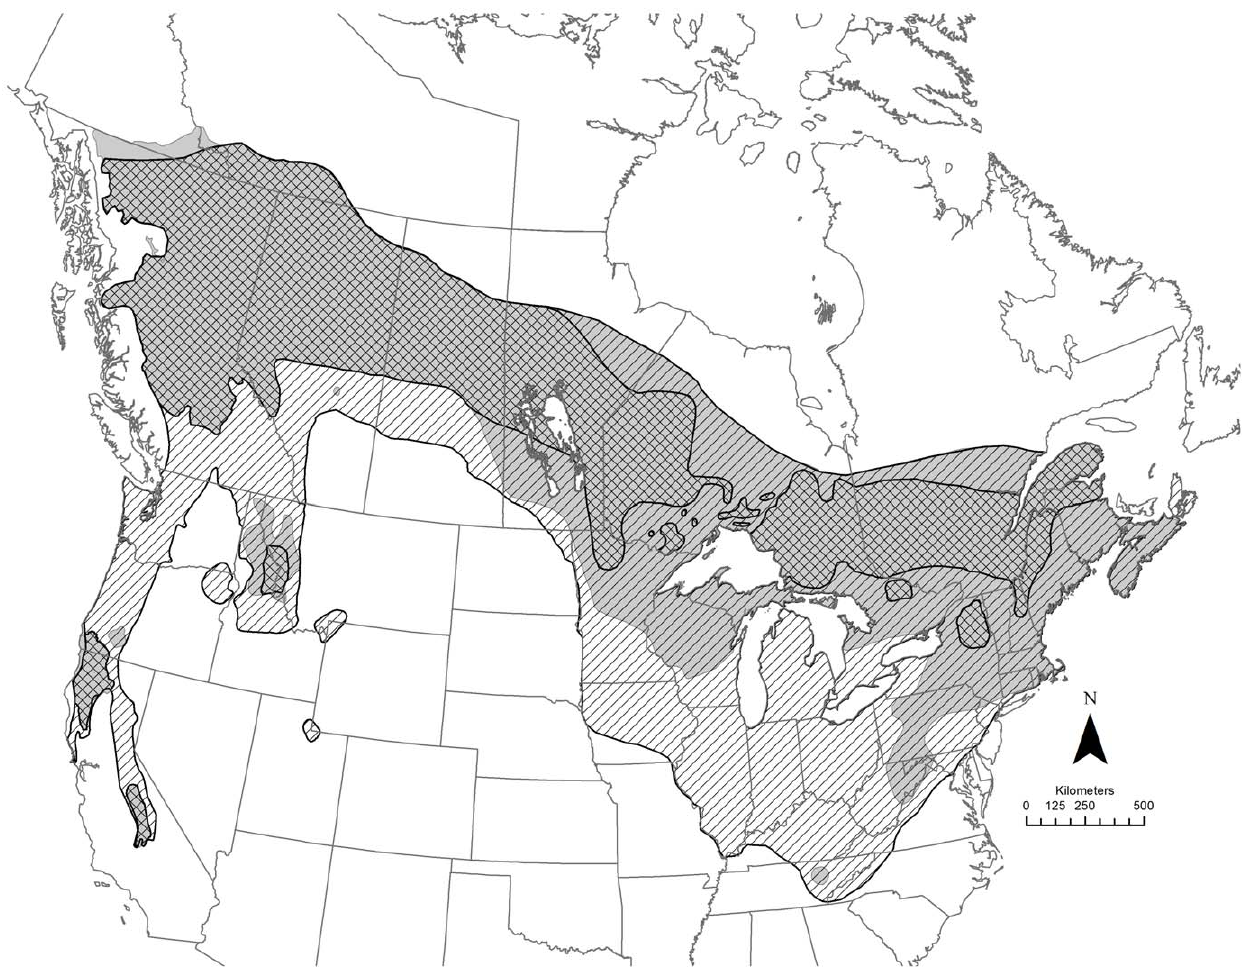
Figure 8. The fisher’s historical (diagonal hatching), most-contracted (cross hatching) and current (shaded) ranges. Significant portions of these ranges were obscured by translocation symbols in Figure 6.